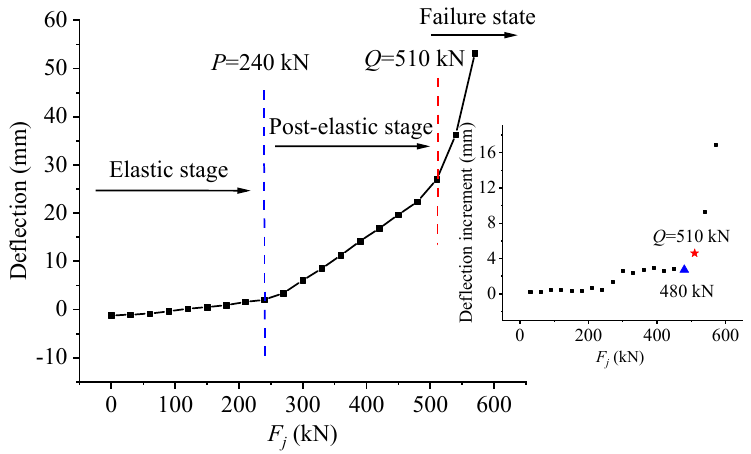
Figure 5. The load ‐ deflection diagram of unbonded No. 4 beam (UP4).